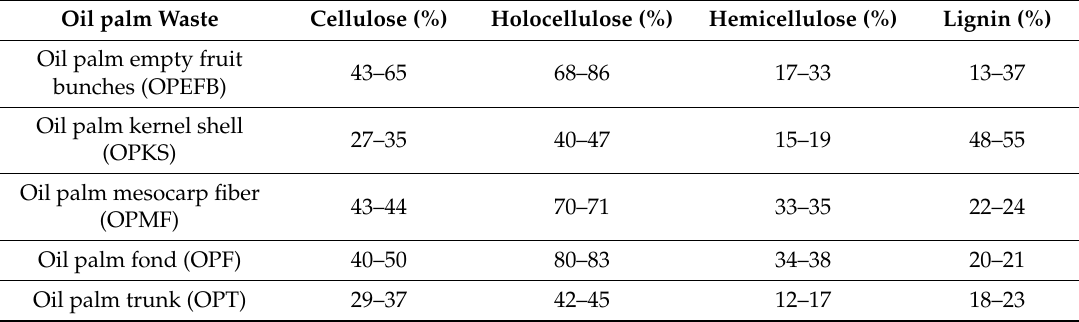
Table 4. The chemical composition in oil palm